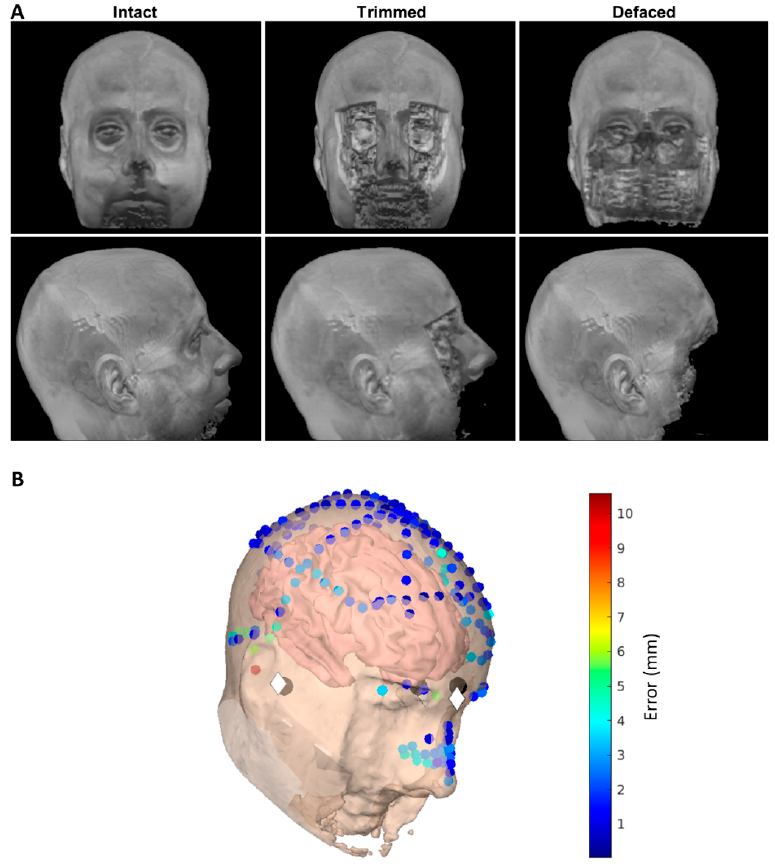
Figure 1. ( A ) Example surface renderings of original, “Trimmed” (that maintains the nose) and standard “De-faced” MRI (columns) from front (top row) or side (bottom row) views. ( B ) locations on semi-transparent scalp surface from trimmed MRI in (Panel ( A )) (plus cortex inside) of three anatomical fiducials digitized during an MEG experiment (dark grey circles), same fiducials indicated on MRI (white diamonds) and head- and nose-points digitized during MEG (small, coloured circles). Colour of head/nose-point circles shows error (in mm) from scalp surface after